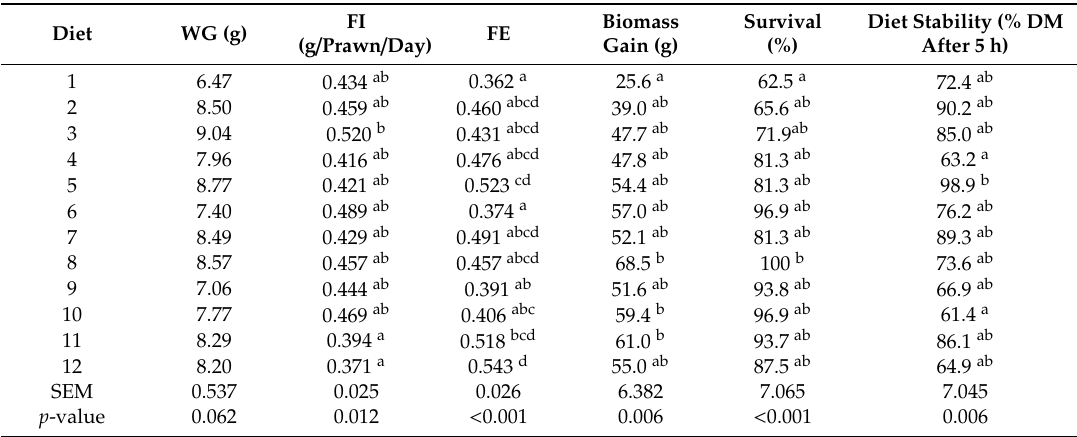
Table 4. E ff ect of twelve dietary treatments on growth performance and survival of juvenile prawns at Day 42 and diet stability, as analyzed by a one-way